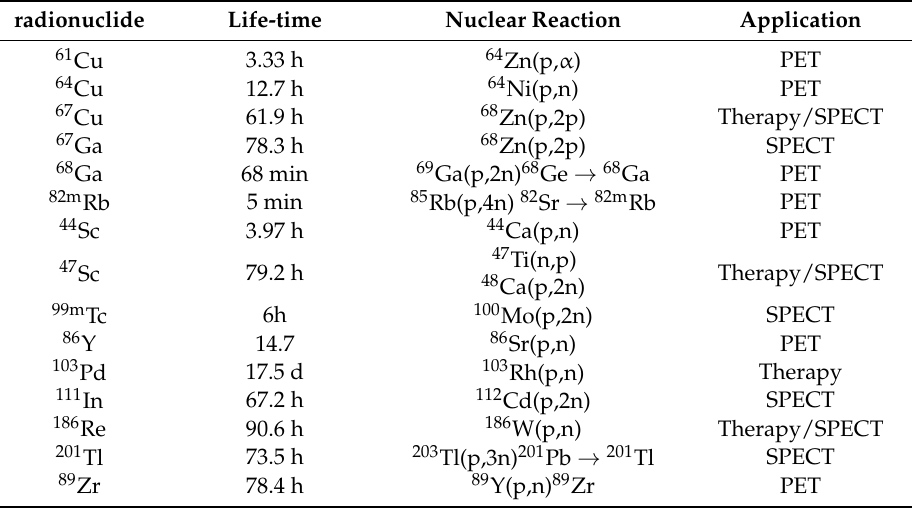
Table 1. List of cyclotron-produced radiometals and some of possible nuclear reactions [9]. radionuclide Life-time Nuclear Reaction Application 61 Cu 3.33